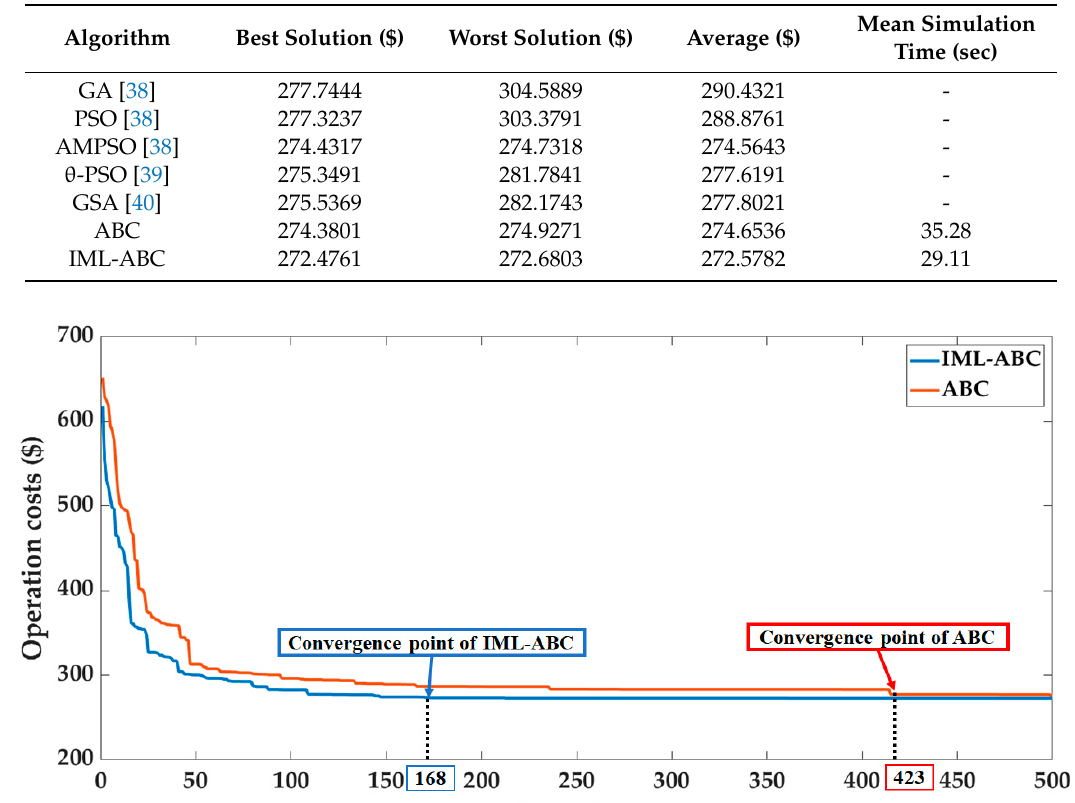
Table 9. Comparison results for various algorithms.